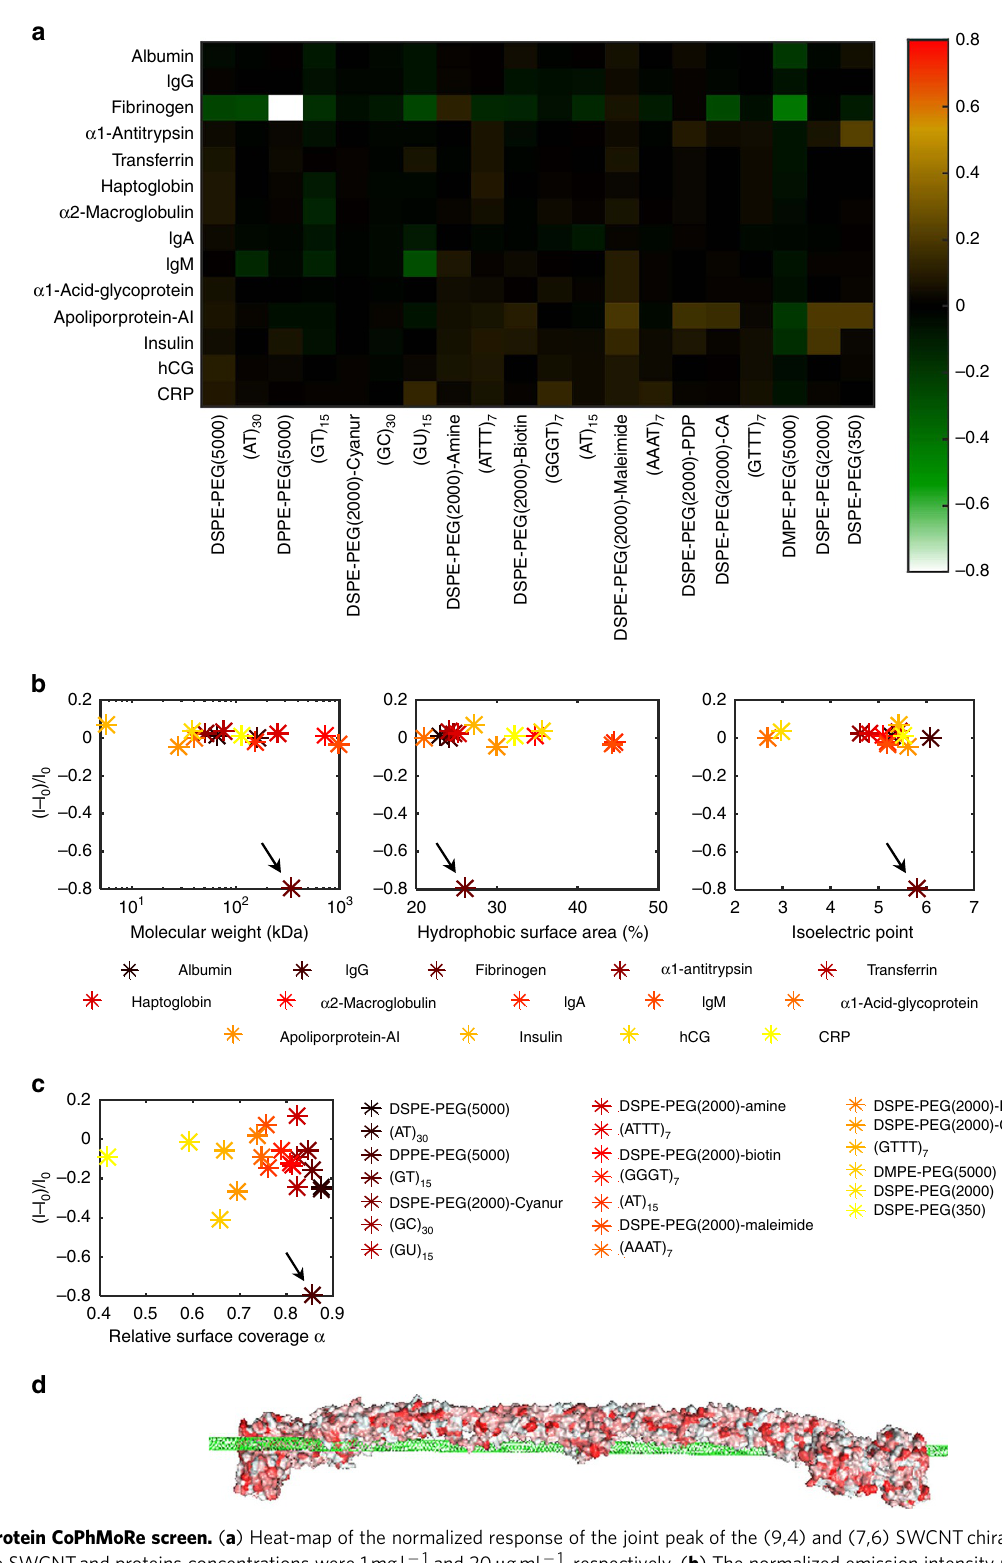
Figure 2 | Protein CoPhMoRe screen. ( a ) Heat-map of the normalized response of the joint peak of the (9,4) and (7,6) SWCNTchiralities to the various proteins. The SWCNTand proteins concentrations were 1mgl (cid:2) 1 and 20 m gml (cid:2) 1 , respectively. ( b ) The normalized emission intensity response ( I (cid:2) I 0 )/ I 0 , where I and I 0 are the final and initial fluorescent intensities, respectively, of DPPE-PEG(5000)-SWCNTversus the protein parameters: molecular weight, relative hydrophobic surface area and isoelectric point. The black arrows point to the fibrinogen data points. ( c ) The normalized emission intensity response of the various SWCNT suspensions to fibrinogen versus the relative surface coverage. The black arrow points to the DPPE-PEG(5000) data point. Each value represents the average of three replicates. ( d ) Illustration of the possible fibrinogen—SWCNT interaction. The fibrinogen surface is coloured according to the hydrophobicity of each amino acid ranging from white (hydrophilic) to red (hydrophobic).